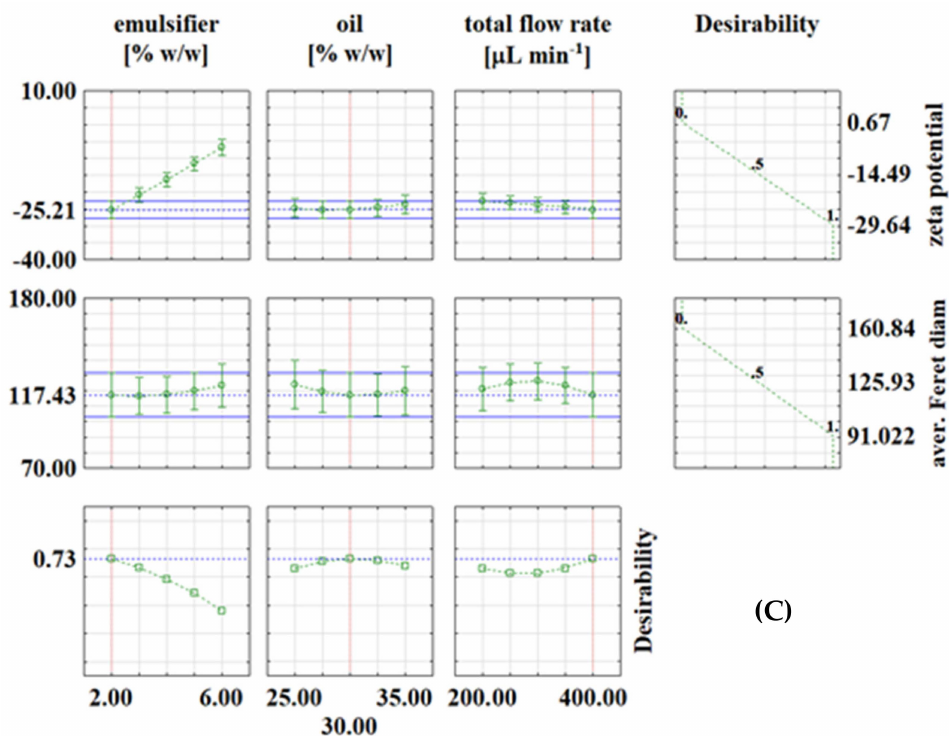
Figure 3. Desirability profiles for continuous experiments with: ( A ) PEG1500; ( B ) PEG6000; ( C )